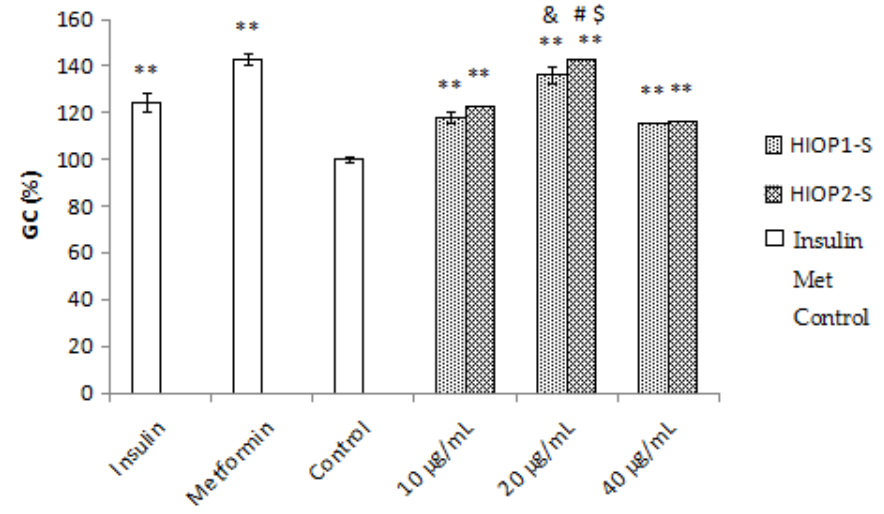
Figure 8. Effects of HIOP1-S and HIOP2-S on the glucose consumption of HepG2 cells. ** p < 0.01, DC